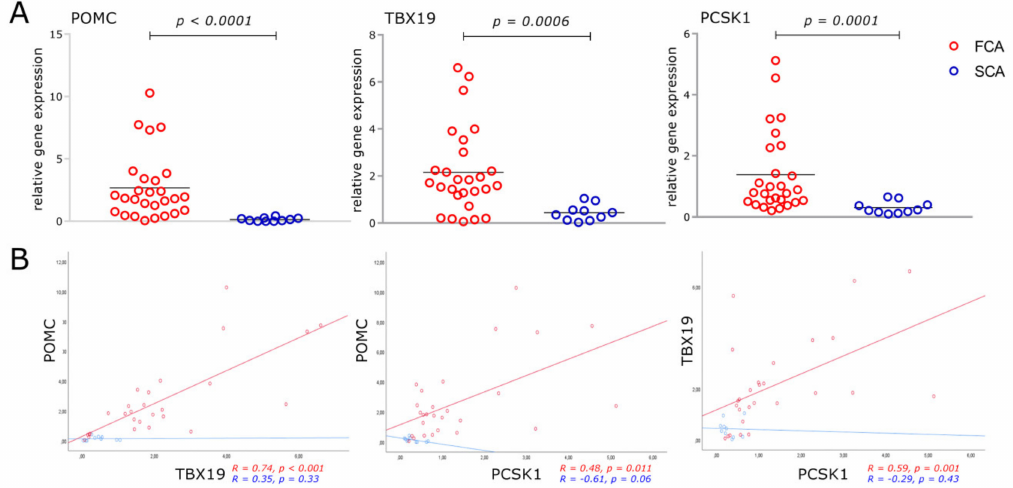
Figure 1. mRNA expression of POMC, TBX19 and PCSK1 in functioning (FCA) and silent (SCA) corticotroph adenomas. Data are presented as a scatter dot plot and mean ( A ) and correlation plots with linear regression lines ( B ). A Mann–Whitney nonparametric test and Spearman correlation were performed; FCA n = 27; SCA n =